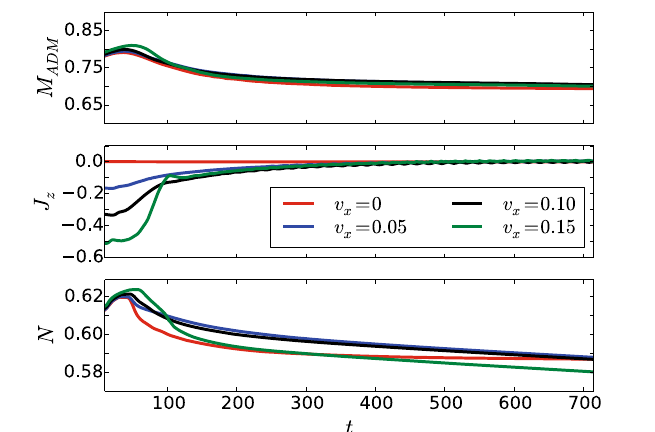
Fig. 21 ADM mass (top panel), angular momentum J z (middle panel), and Noether charge (bottom panel) asfunctionsoftimefortheorbitalbinarycollisionsofcompactsolitonicbosonstarswithdifferenttangential boost velocities. During the coalescence, approximately 5% of the mass and Noether charge is radiated, as well as most of the angular momentum. Reprinted with permission from Bezares et al. (2017); copyright by